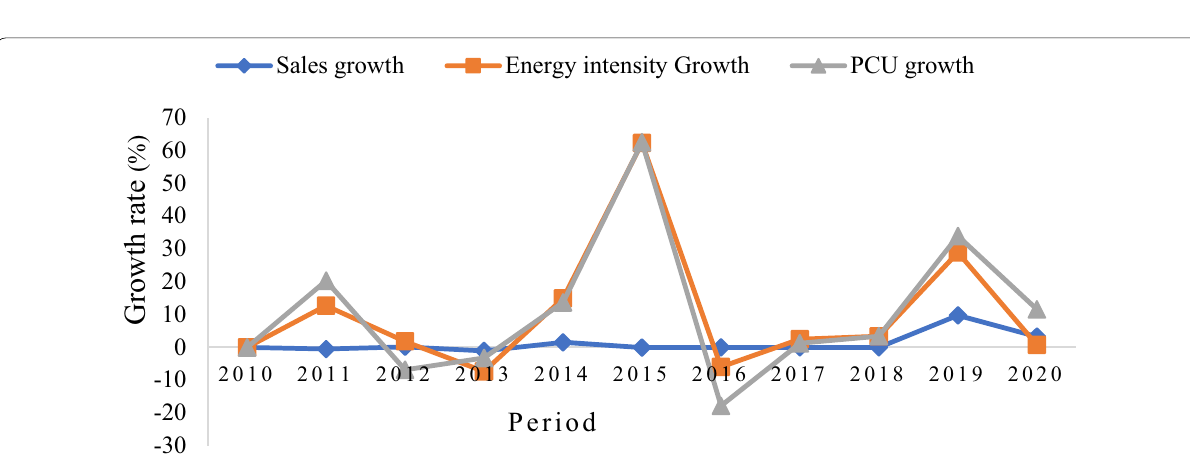
Fig. 5 Structural change in chemical and